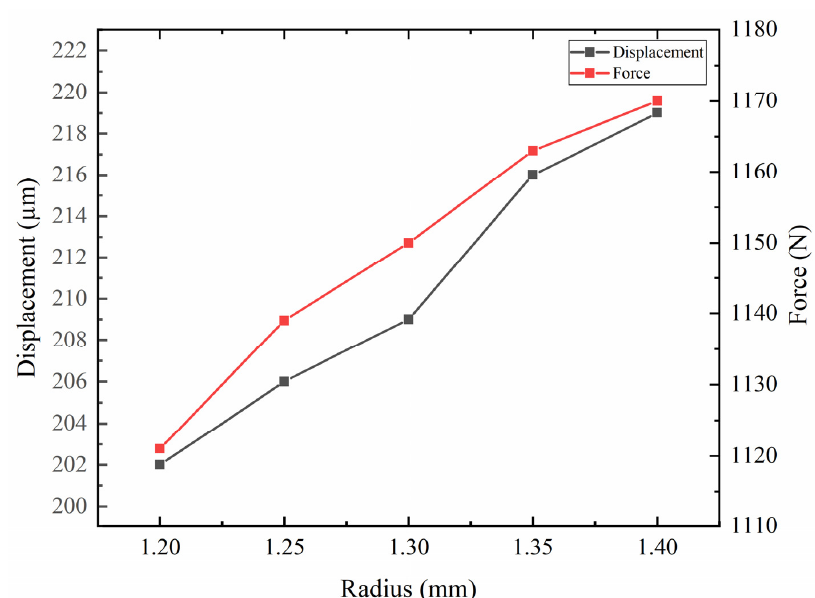
Figure 13. Parametric analysis of hinge radius.